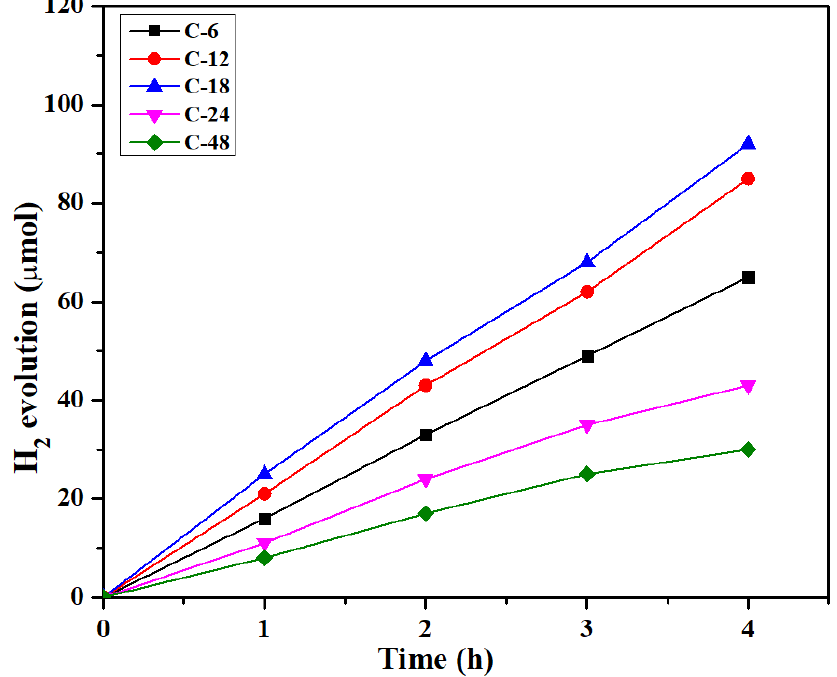
Figure 11. Time course of H 2 evolution of CdS nanorod samples prepared at different reaction times.